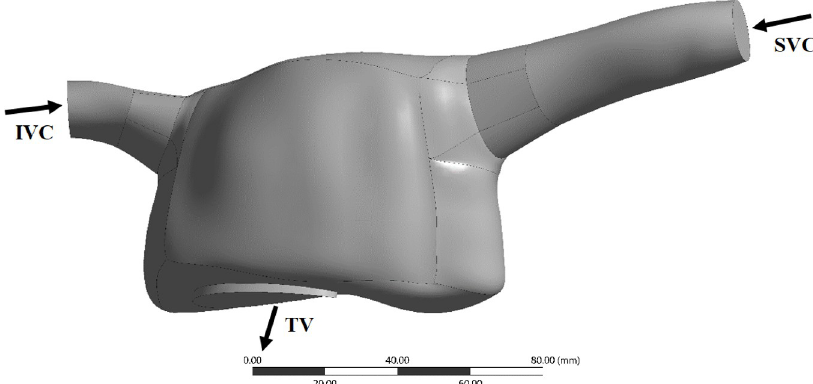
Fig 1. RA computational domain. IVC, inferior vena cava; SVC, superior vena cava; TV, tricuspid valve.